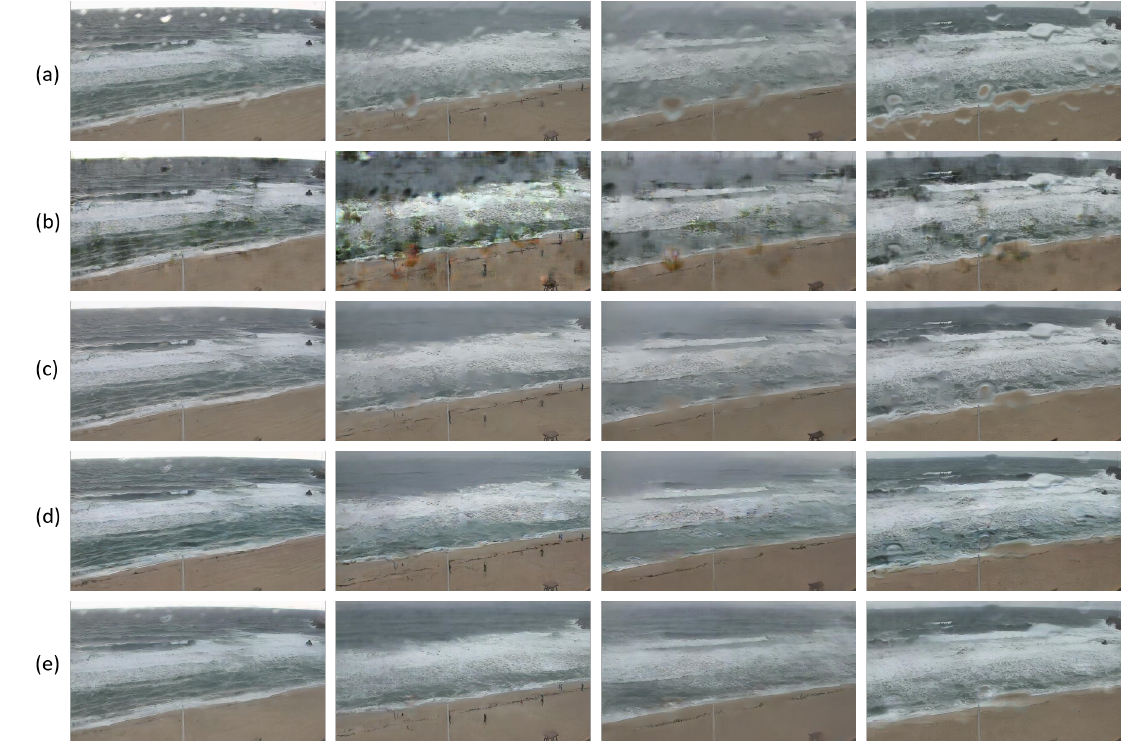
Figure 9. Test examples of the CCTV monitoring coastal areas at Anmok Beach: ( a ) Distorted examples; and the reconstructed images of ( b ) Pix2Pix ; ( c ) Attentive GAN ; ( d ) pre-trained Raindrop-aware GAN ; and ( e ) fine-tuned Raindrop-aware GAN